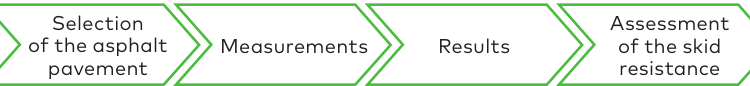
Selection of the asphalt Figure 2. Plan of experiment and methodology